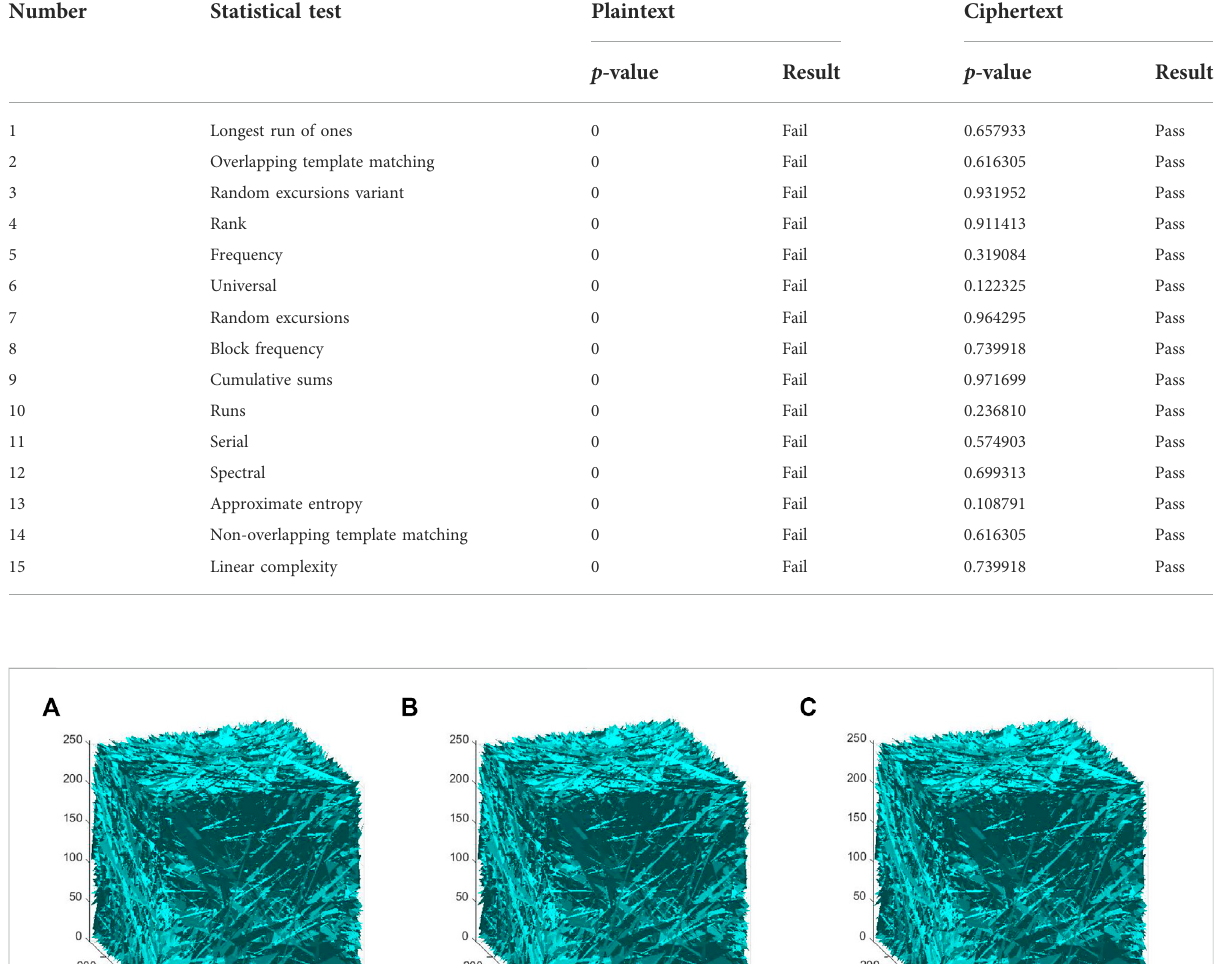
TABLE 6 Correlation coef fi cients comparison.